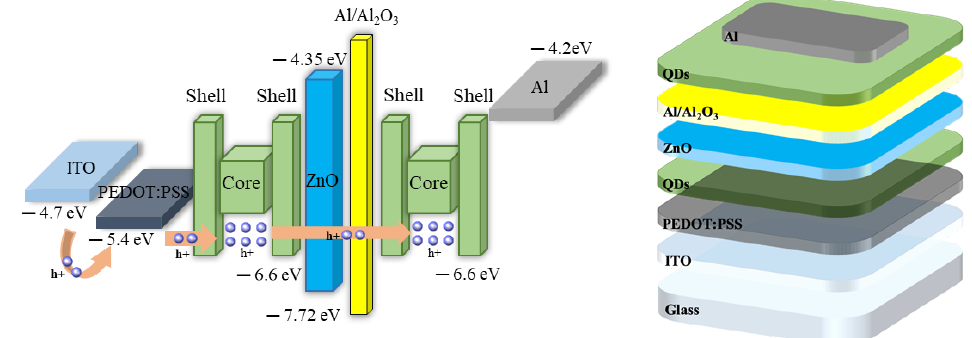
Figure 3. Schematic diagram and the energy band diagram of fabricated memory devices.